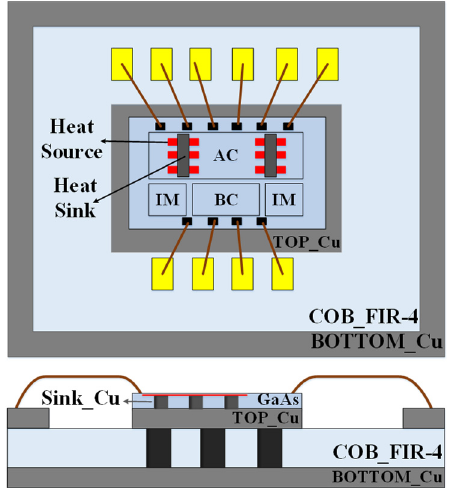
Figure 4. Simplified modeling topology of proposed method.